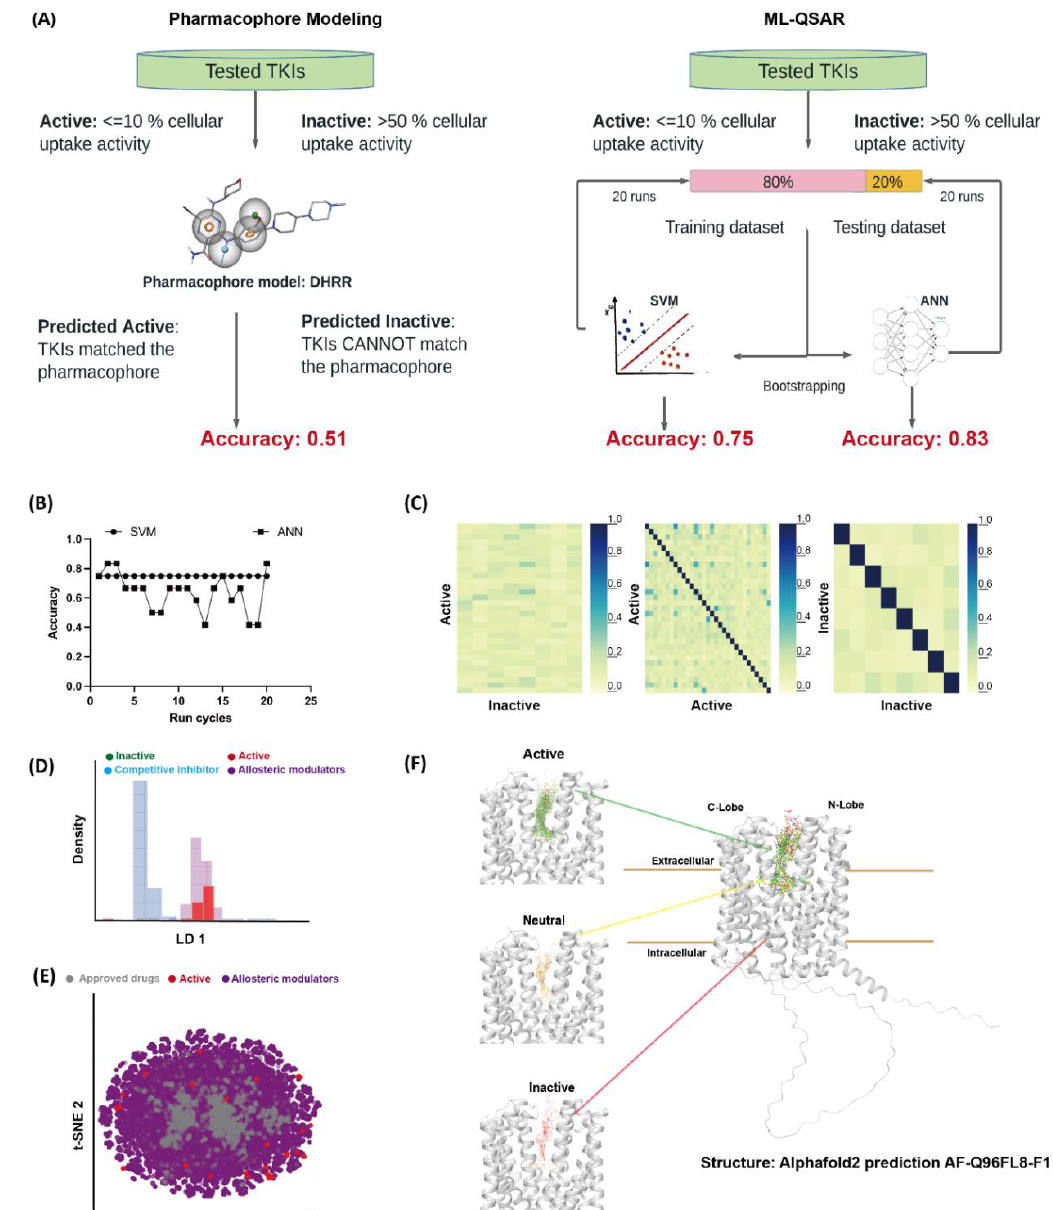
Figure 2. In silico analysis of mechanisms underlying MATE1 inhibition by TKIs. ( A ) The workflow of pharmacophore and ML-QSAR modeling. ( B ) The accuracy for the test dataset for 20 ML-QSAR runs. ( C ) The Tanimoto similarity comparisons of TKIs. ( D ) Probability distributions of active TKIs, inactive TKIs, allosteric modulators and competitive inhibitors using LDA. ( E ) Chemical space of the TKIs, allosteric modulators and approved drugs projected along the first two PC modes from PCA using t-SNE. ( F ) The clustering of the best binding poses for active, inactive, and neutral TKIs in a hMATE1 model. See Section 2 for details.